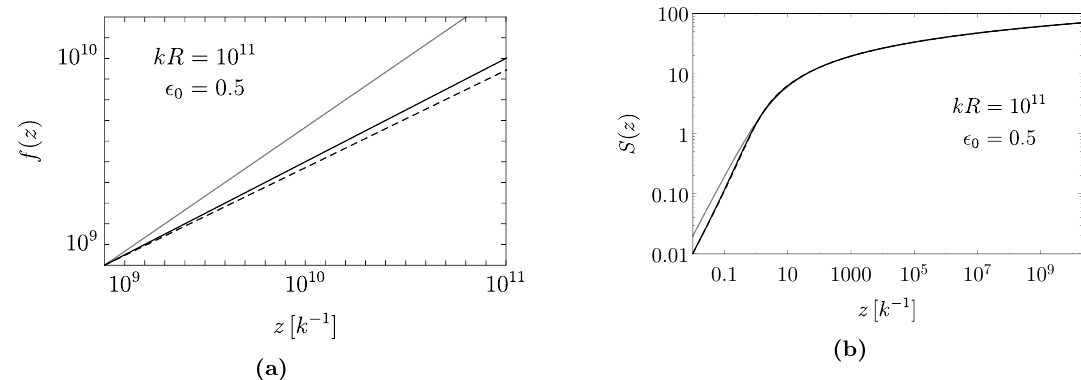
Figure 4. Metric warping (a) and Dilaton pro(cid:12)le (b) of the Linear Dilaton model with in(cid:13)ation (black) as compared to the static solution (gray). Next to our perturbative results (black) we also show a numerical solution (black, dashed). For the chosen parameters, the resulting Hubble rate is H (cid:25) 4 (cid:2) 10 (cid:0) 12 k (cid:25) 4 (cid:2) 10 (cid:0) 9